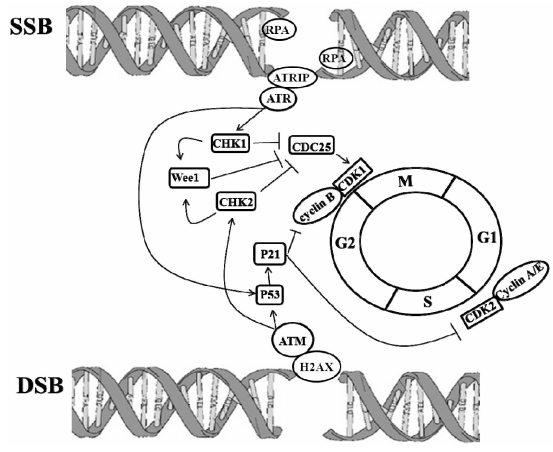
Figure 2. Molecular cascades of DNA damages initiating repair systems and cell cycle progression. In response to DNA damage, including single-strand beaks (SSBs) and double-stranded breaks (DSB), the Ataxia-telangiectasia-mutated protein kinase (ATM)/ Ataxia-telangiectasia and Rad3 related protein (ATR) signaling pathways are activated, leading to the phosphorylation and activation of CHK1 and CHK2 and to the subsequent phosphorylation of CDC25. Phosphorylated CDC25 inhibits activation of cyclin B/CDK1, resulting in G2 arrest. Activated ATM/ATR pathways also activate p53-dependent signaling to arrest G2 through the activation of P21, which inhibits cyclin B/CDK1 complexes. Lines with arrow heads indicate activation, while lines with bar heads indicate